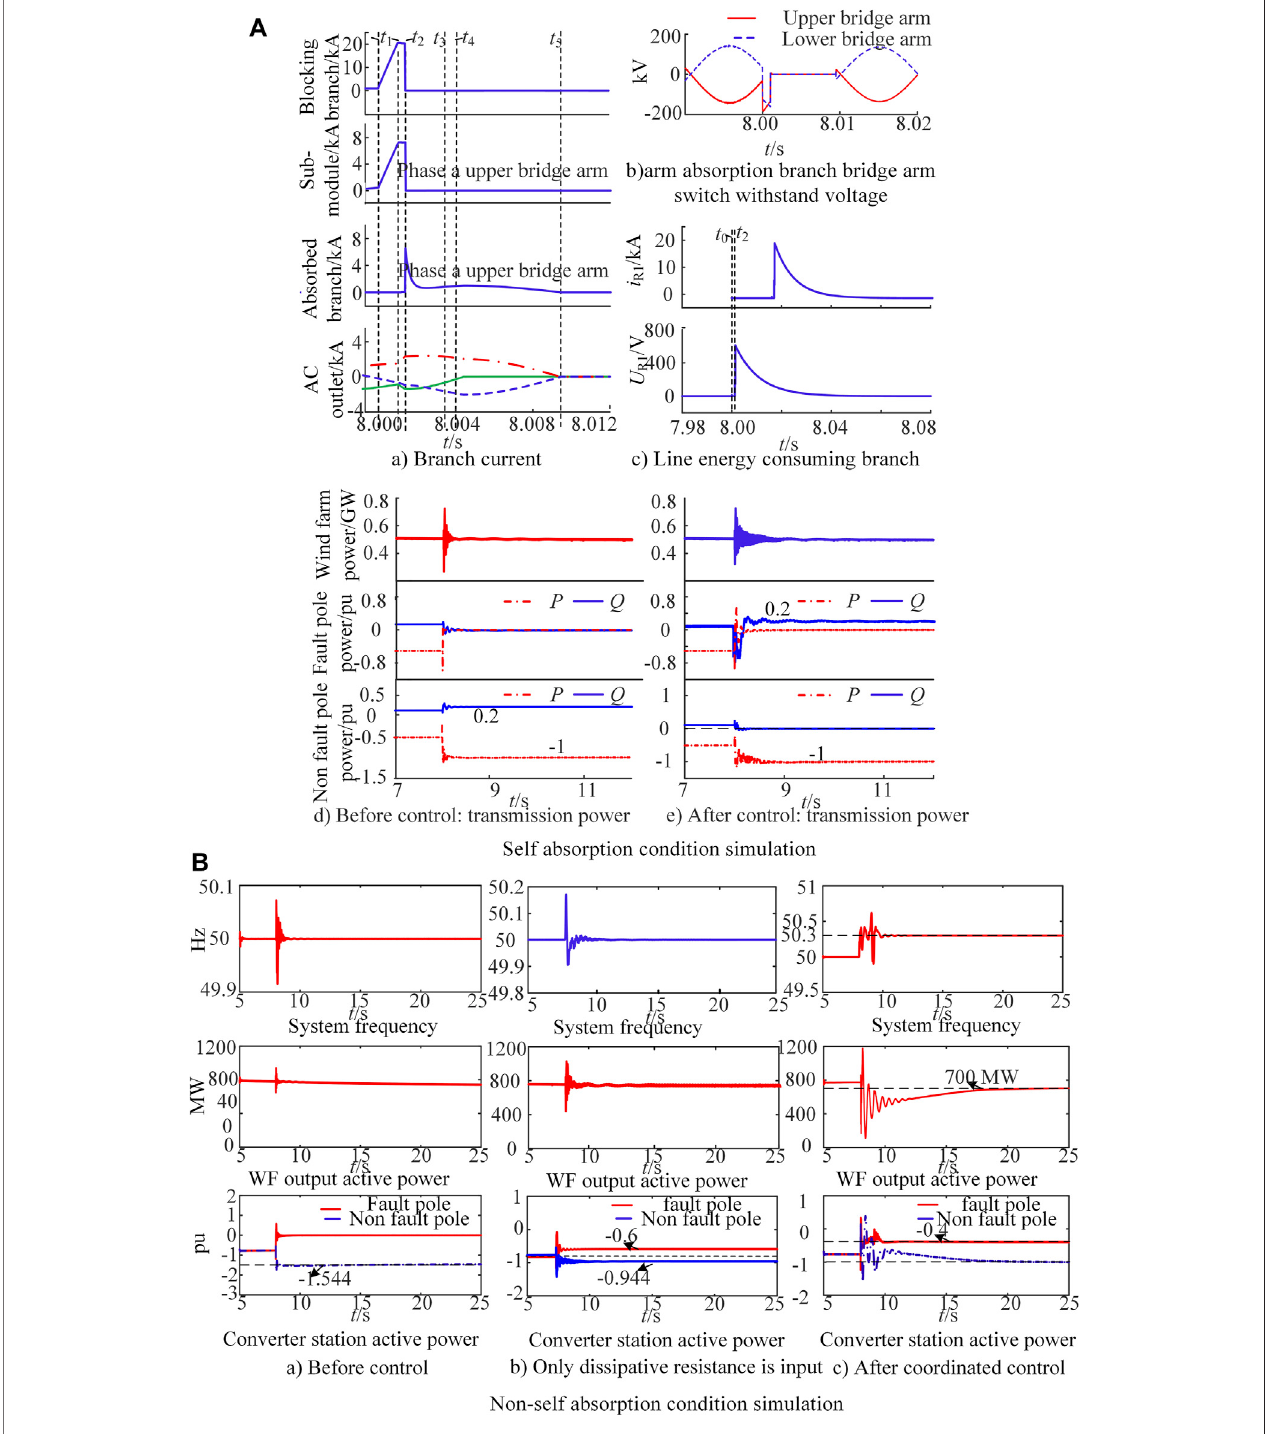
FIGURE 4 | Simulation veri fi cation of the DC fault ride-through coordinated control strategy.